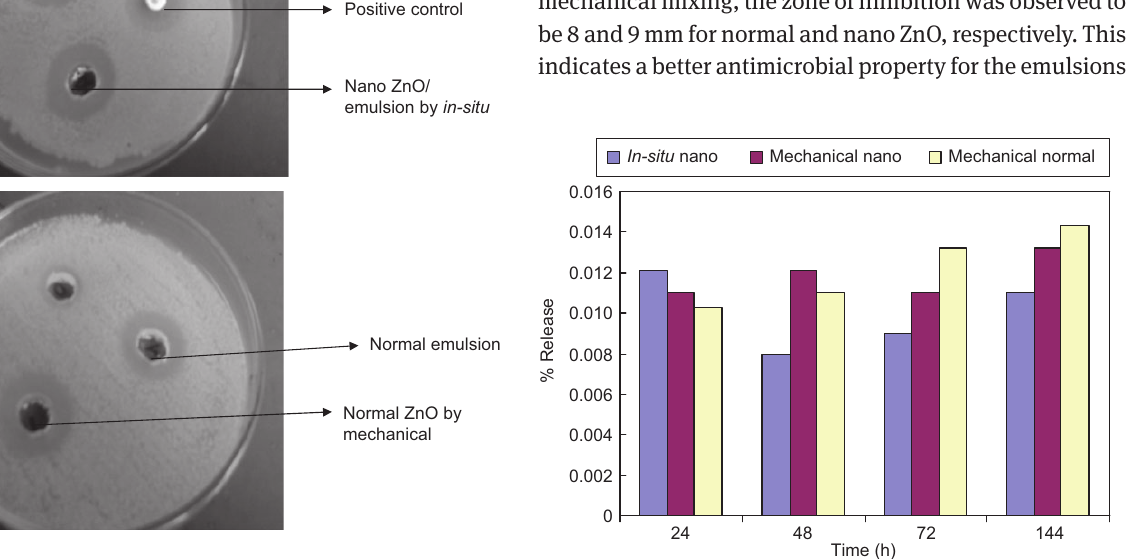
Figure 2 Images of Escherichia coli incubated (A) with nano ZnO/emulsion by mechanical and in situ method (B) with normal emulsion and by mechanical method with normal ZnO.